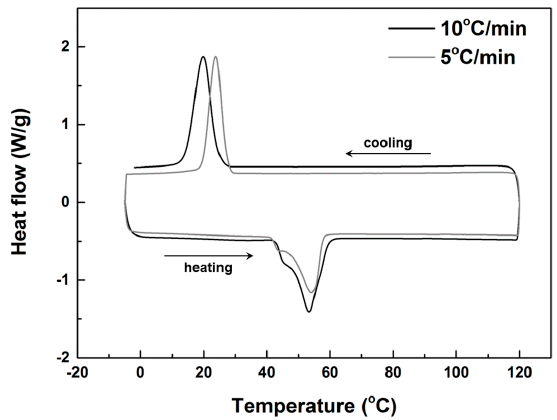
Figure 2. DSC results of PPM002040 at heating/cooling speeds of 10 °C/min (black line) and 5 °C/min (grey line).